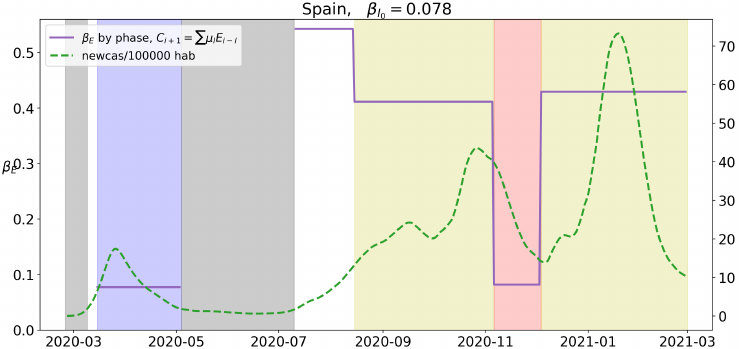
Figure 18. Value of β E for the different levels of lockdown. Blue background will correspond to Stage 1, red to Stage 2, yellow to Stage 3 and white to Stage 4. A green dotted line corresponds to the value of new cases per 100,000 hab.